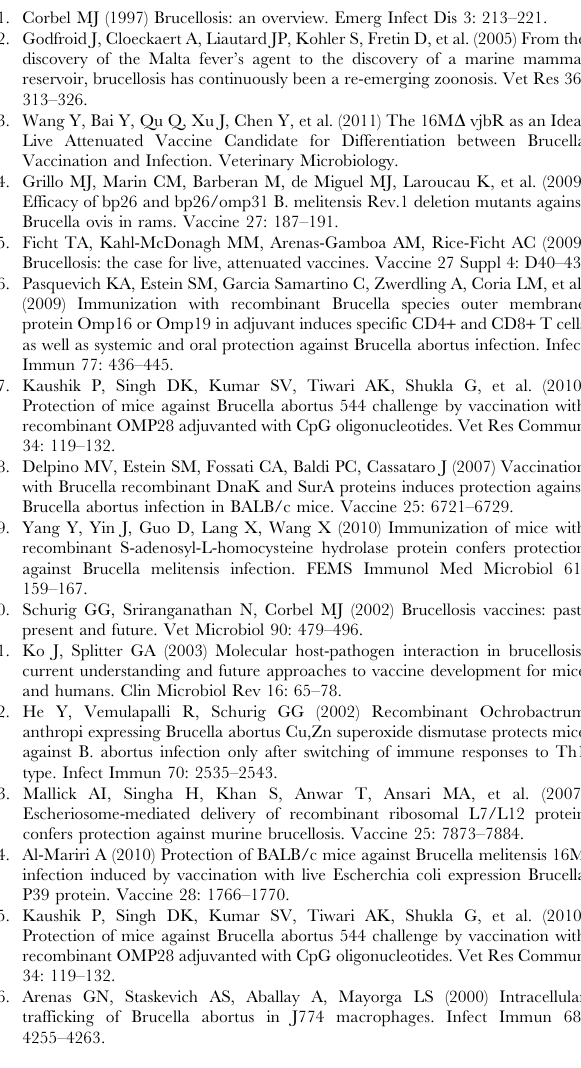
Table S1 Proteins information and amplification primers of the selected